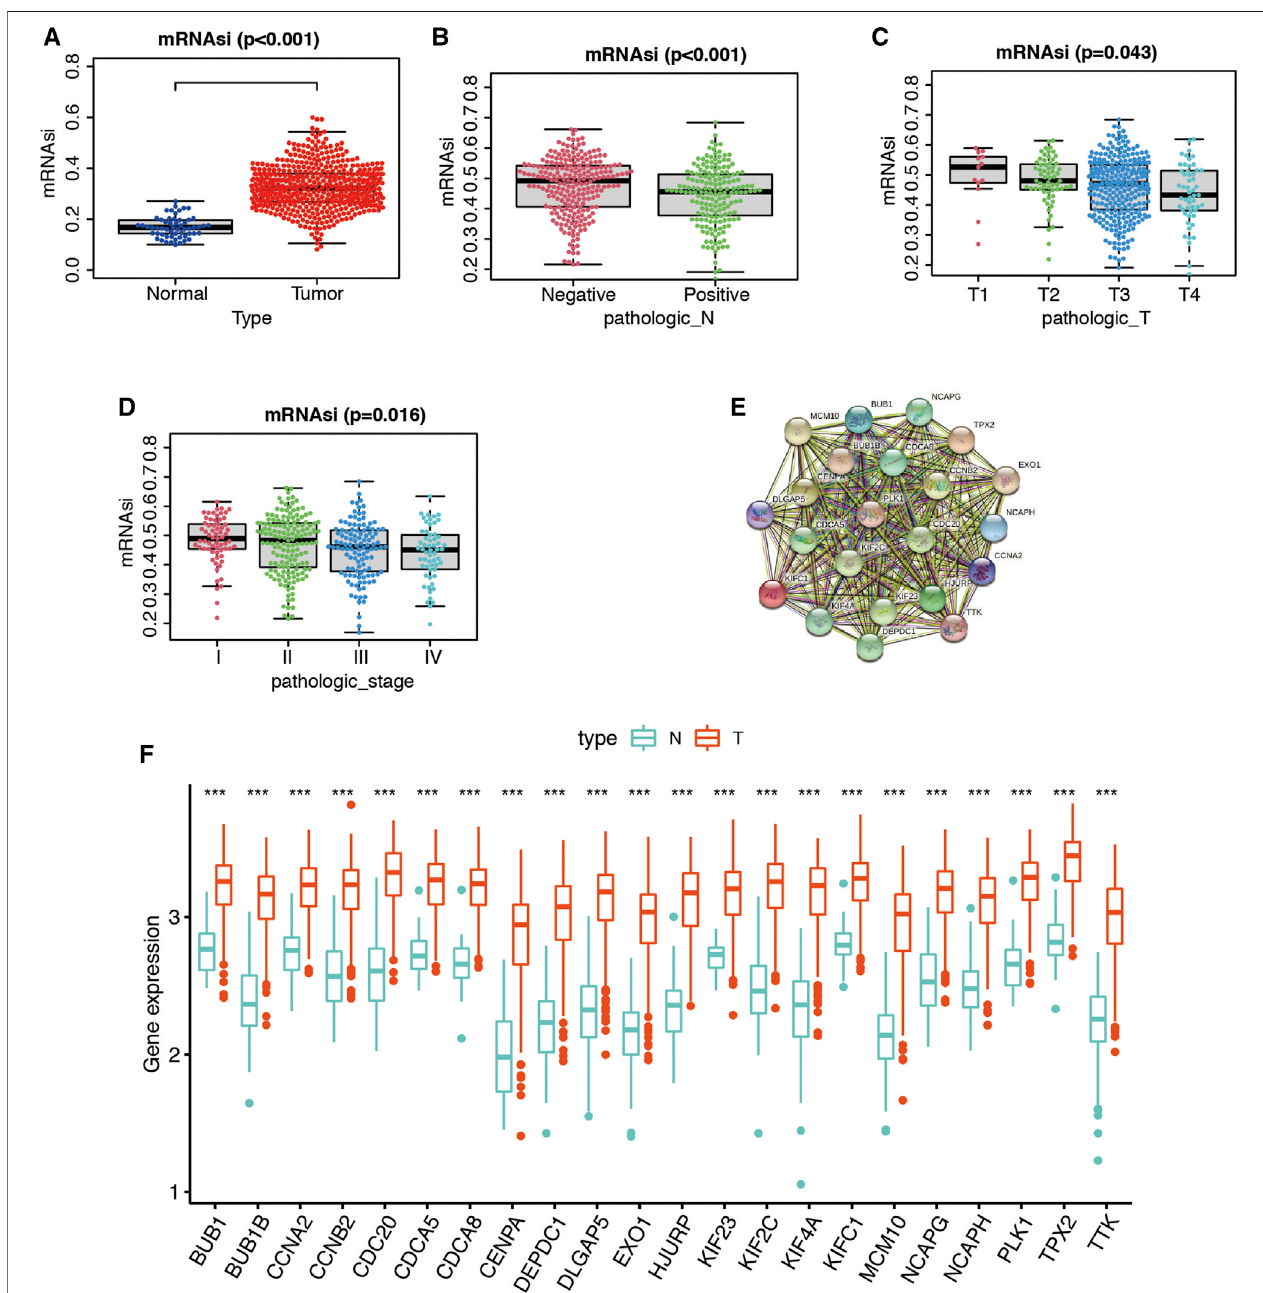
FIGURE 4 | mRNAsi differences in different clinicopathological features. (A) Differences in the mRNAsi between normal and LUAD tissues. (B) Differences in the mRNAsibetweendifferentlymphnodemetastasis. (C) DifferencesinthemRNAsiamongdifferentTstages. (D) ComparisonofthemRNAsiamongfourAJCCstages. (E) Protein – protein interactions between 22 hub genes in turquoise module. The thickness of the solid line represents the strength of the relationship. (F) Differential expression of 22 hub genes between normal and tumor cases in the LUAD dataset of TCGA shown by box-plots.